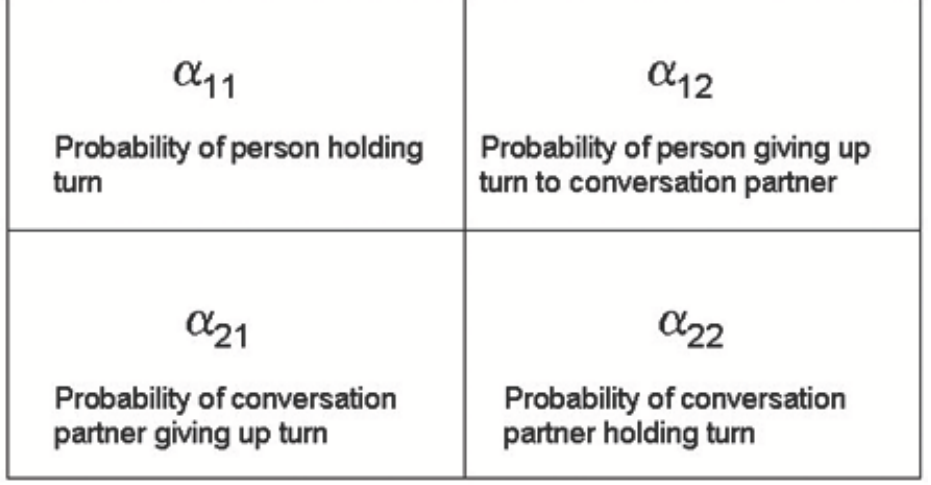
Figure 6. The significance of (cid:11) parameters in the case of a two-person